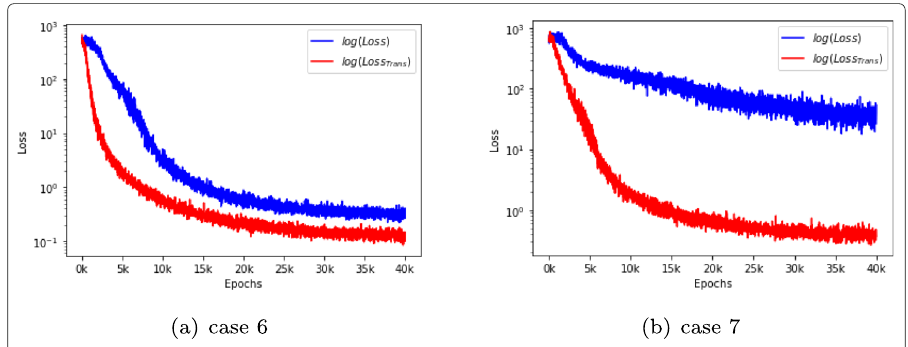
Fig. 7 The convergence of GP-PINN (on the log scale) on the Helmholtz equation. Blue : training with random initialization. Red : training with transfer